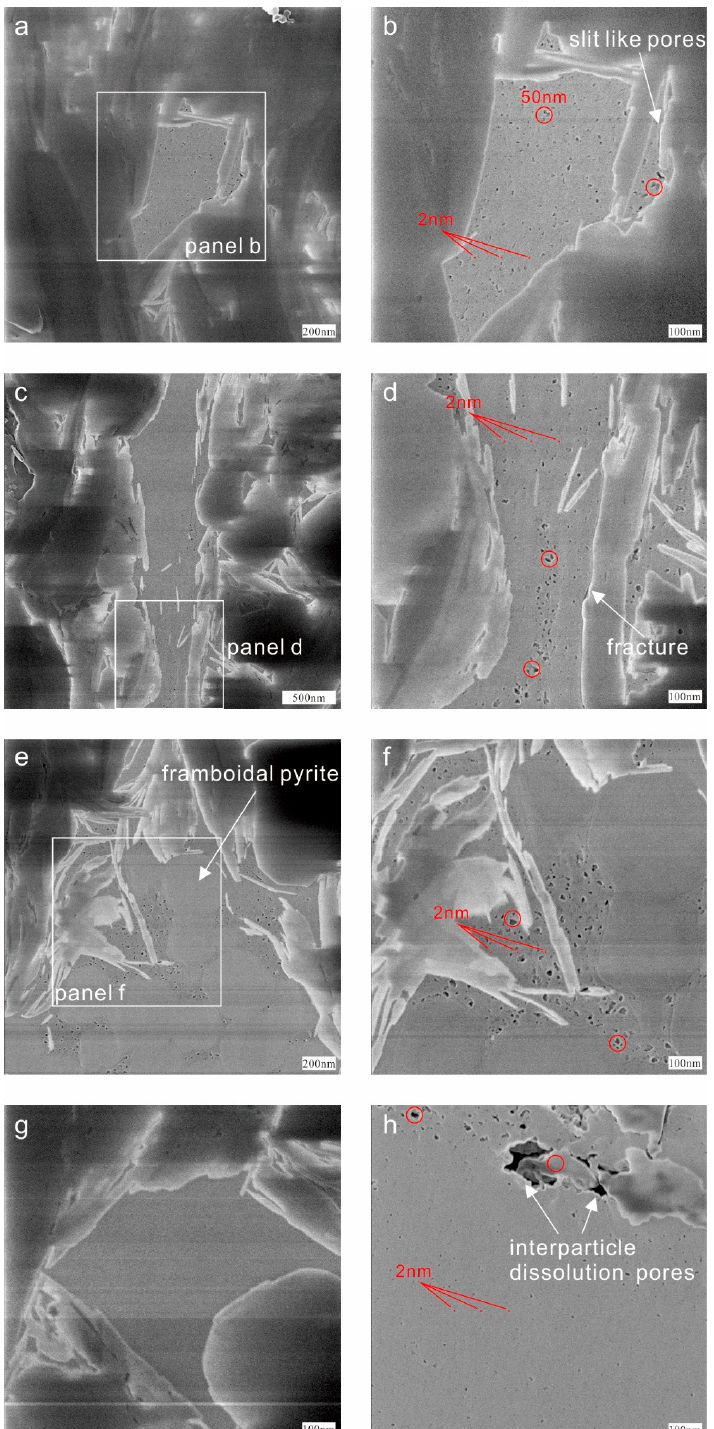
Figure 9. Helium ion microscope (HIM) images of sample L-1, showing abundant porosity with a wide range in the size of micropores and fine mesopores. ( a , b ): Densely developed organic pores with a few slit-like pores forming between organic matter and clay minerals; ( c , d ): Banded organic matter formed by the compaction process. Some directionally distributed pores and fractures are developed in the organic matter; ( e , f ): The organic matter between the particles of framboidal pyrite, and the pores within it; ( g ): Organic matter without pore development; ( h ): Well-developed pores less than ten nanometers in diameter. Some large pores were also formed by dissolution of mineral